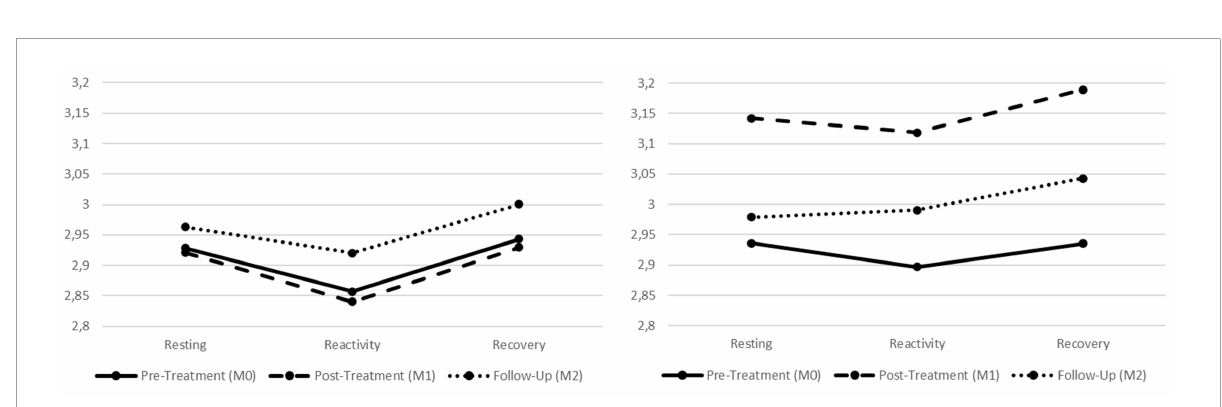
FIGURE4 Graphic presentation of the treatment and control groups’ physiological correlates for the different phases of the standardized procedure (SP), across the pre-treatment, post-treatment, and follow-up assessment periods. Left graph refers to the treatment group and right graph refers to the control group. Both graphs refer to the HFms 2